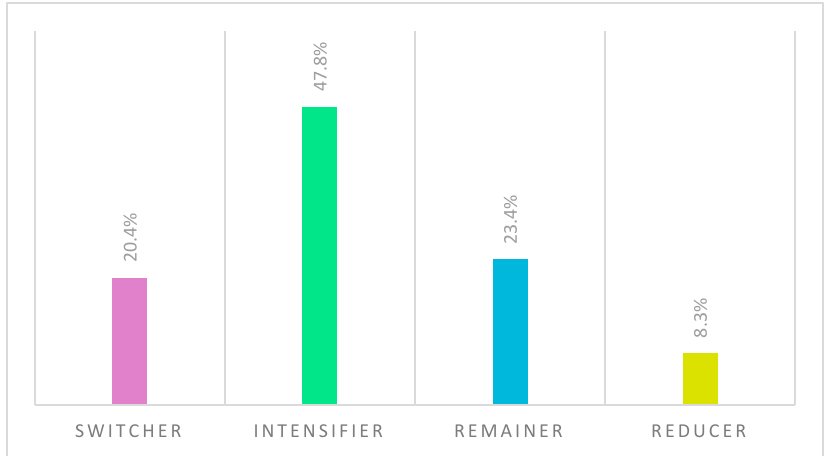
Figure 4. Types of conversion in the UCIP research sample of Muslim prisoners (%).